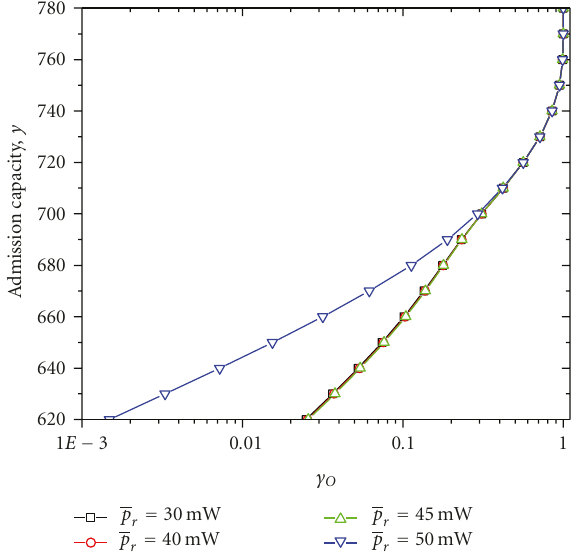
Figure 7: The maximum number of connections y versus γ O with = 50 mW, σ 2 = 10 − 11 , φ = 100Kbps, BER = 1 e − ( p respect to p r s